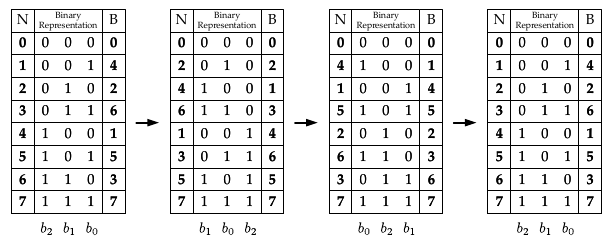
Figure 5. Addressing scheme example for even-indexed memories ( N = 16 and β =